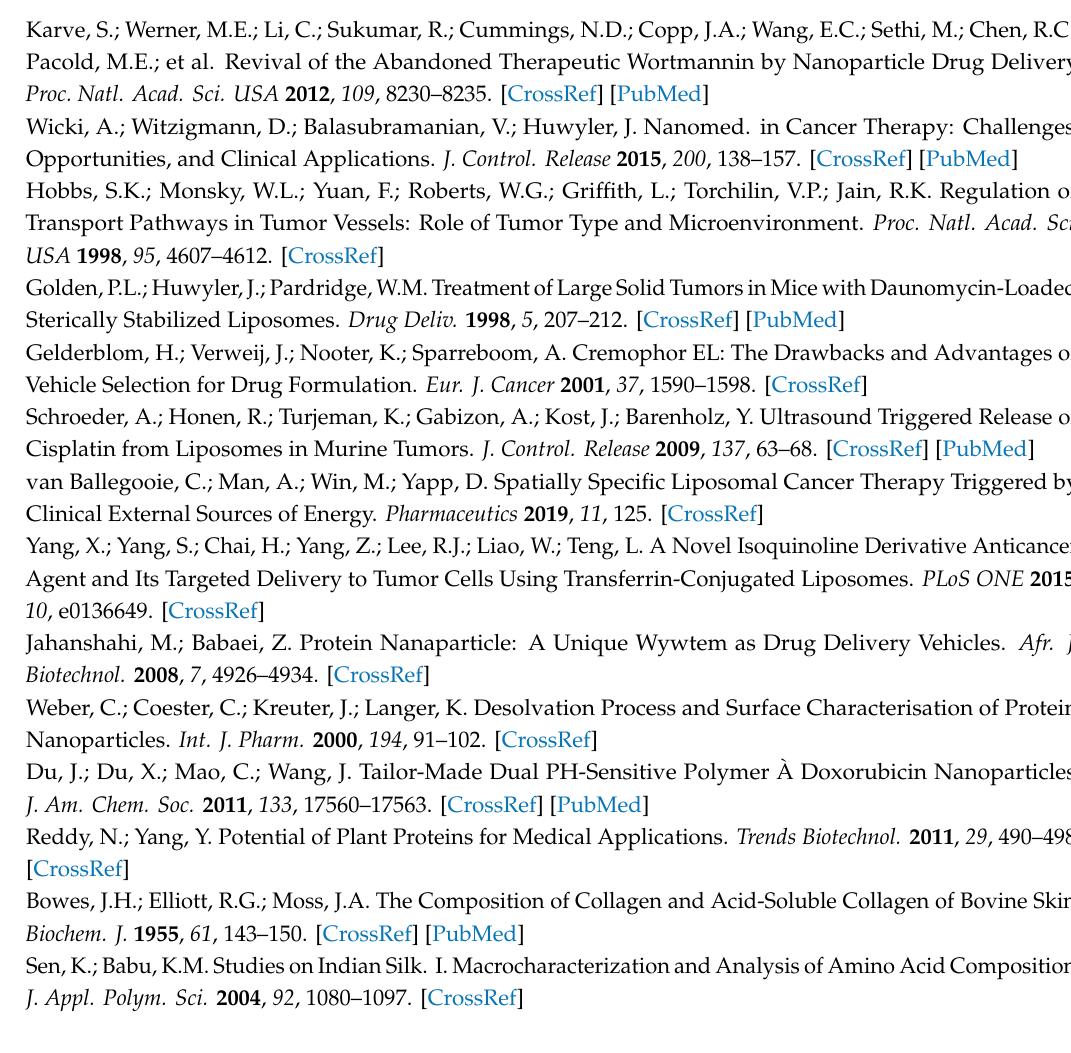
and Clinical Applications. J. Control.